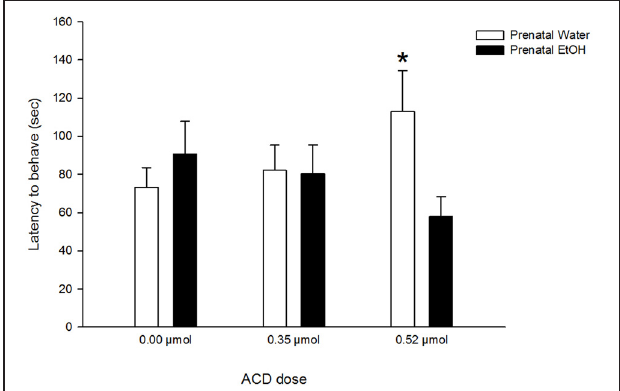
FIGURE 2 | Effect of central ACD administration on motor activity. Data represent mean + SEM of motor behavior (frequency) in consecutive 5min blocks during testing. (A) Motor activity after central ACD administration as a function of prenatal exposure to EtOH. (B) Motor activity collapsed across